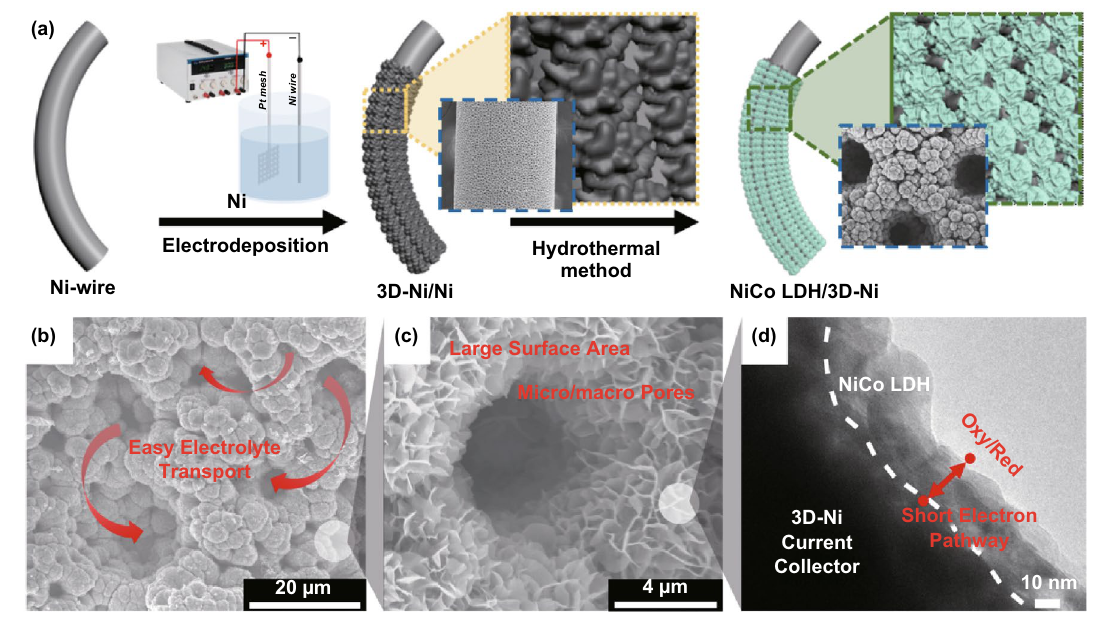
Fig. 1 a Schematic representation of the fabrication of the NiCo LDH/3D‑Ni electrode. b, c FE‑SEM images, and d TEM image of the NiCo LDH/3D‑Ni nanostructures at different